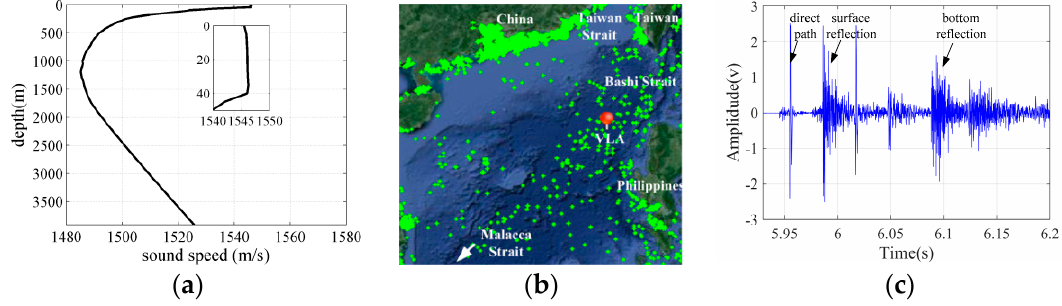
Figure 8. Experimental environment and signal waveform of explosive sources. ( a ) Measured sound speed profile; ( b ) real-time shipping distribution from the satellite AIS system in experiment; ( c ) received signal waveform of brand explosive sources.